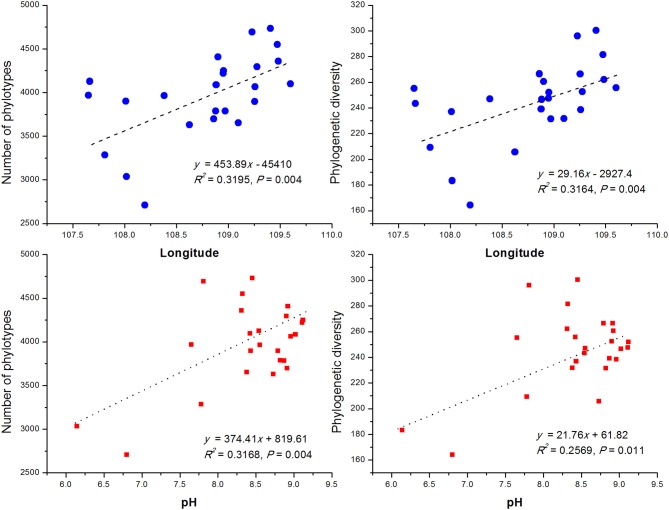
The relationship between longitude of sampling sites, soil pH and soil bacterial OTUs phylotype richness and phylogenetic diversity. The communities were randomly selected at the 45,000 sequences level.